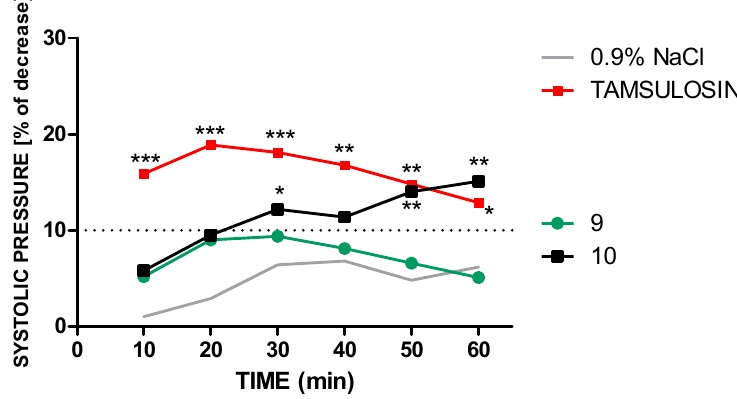
Figure 3. An influence of tamsulosin and compounds 9 and 10 , given in a dose of 2 mg/kg ( i.v. ), on systolic pressure in anaesthetized rats. Significant to control group (0.9% NaCl): * p < 0.05, ** p < 0.02, *** p < 0.01.